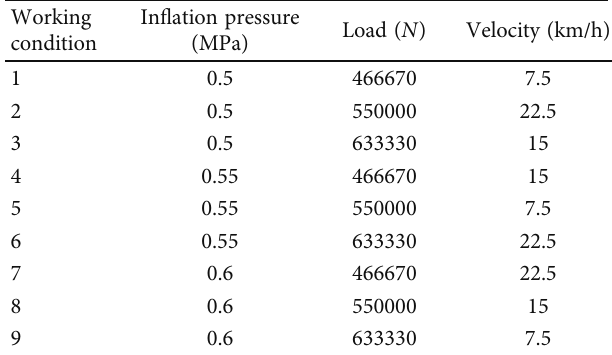
Figure 6: Schematic diagram of angular velocity and velocity imposition.